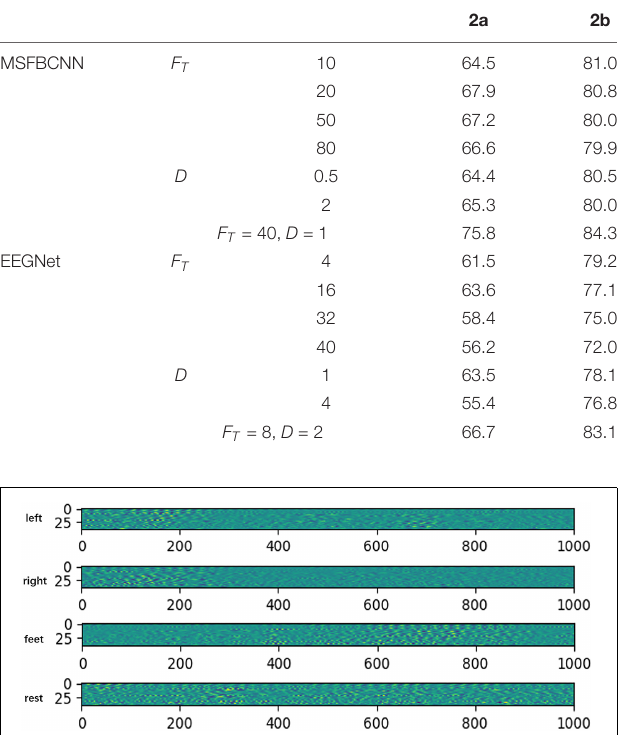
TABLE 6 | Effects of different F T and D with comparison to the original.